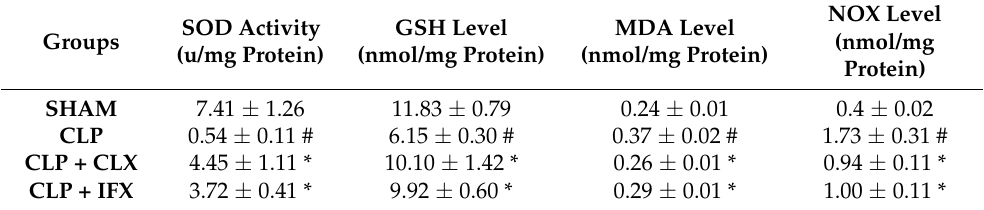
Table 3. CLX and IFX enhance renal oxidative and antioxidant profiles in septic rats.